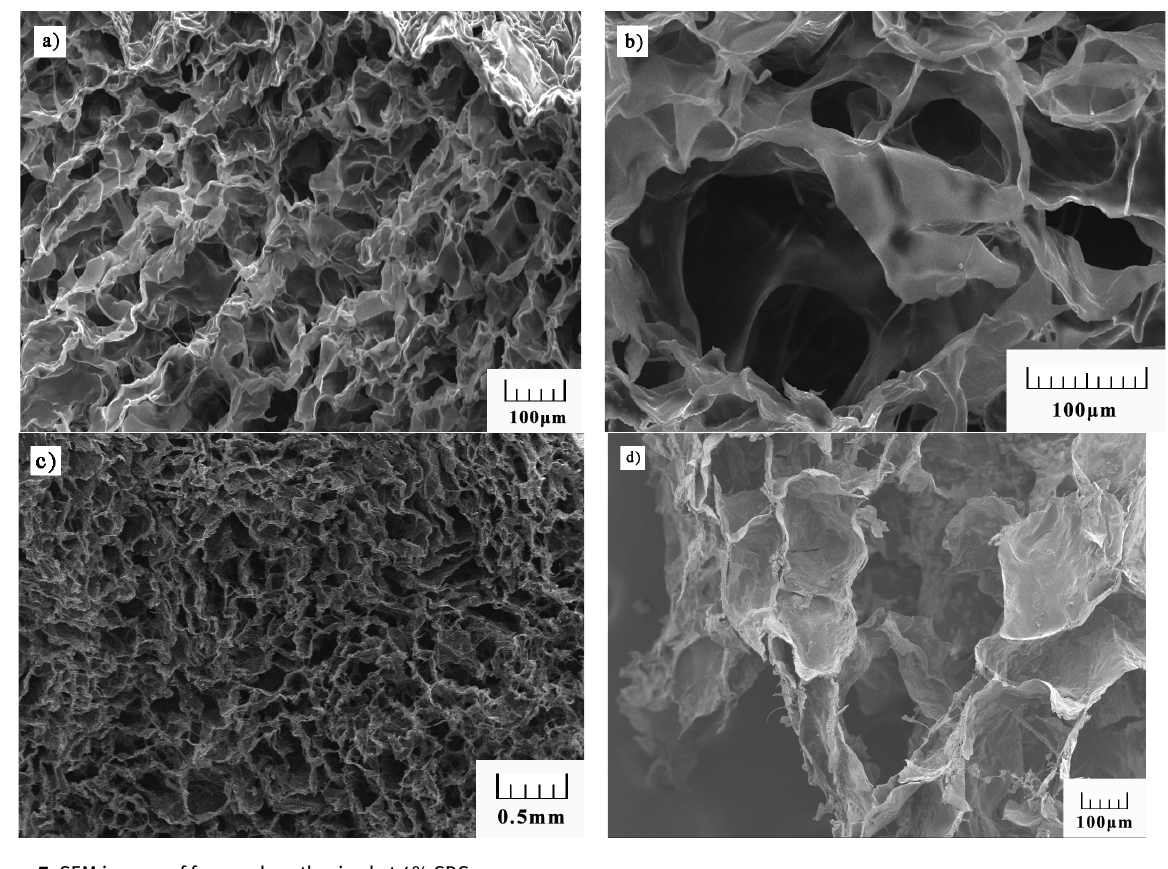
Figure 7: SEM images of foam gel synthesized at 4% SDS